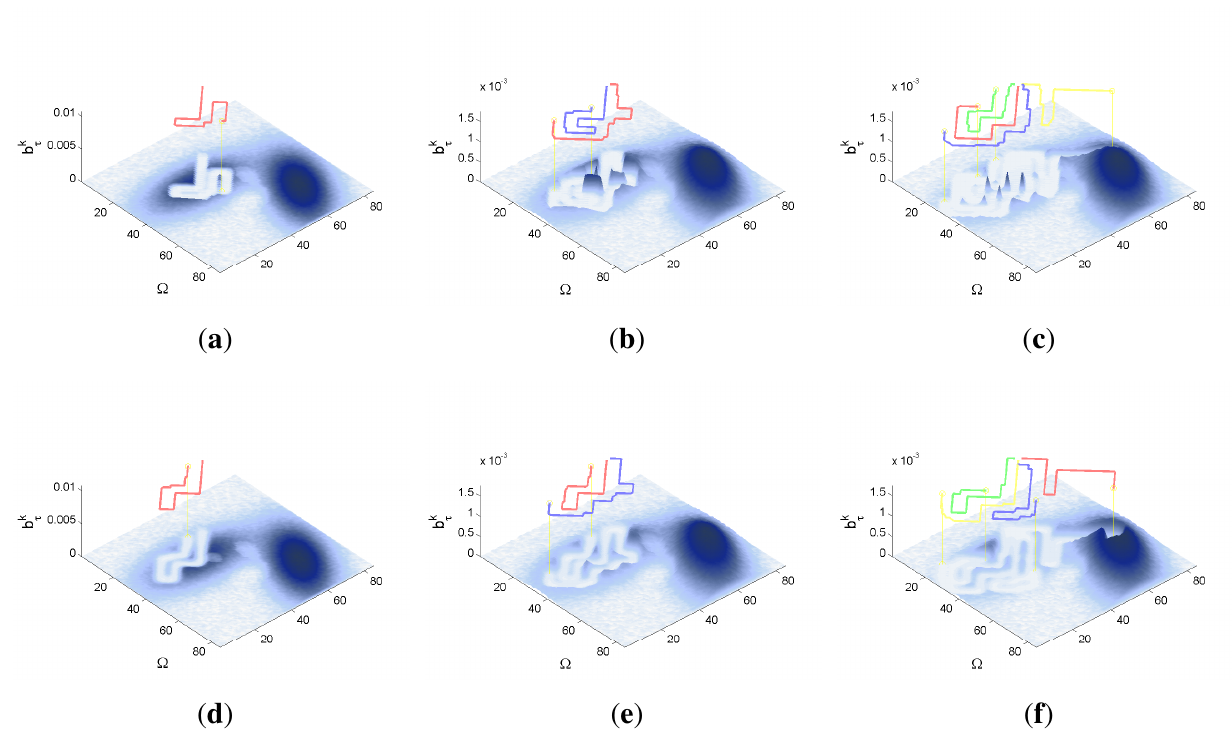
Figure 6. Simulations in the static radar scenario. ( a ) Ideal, M = 1 ; ( b ) Ideal, M = 2